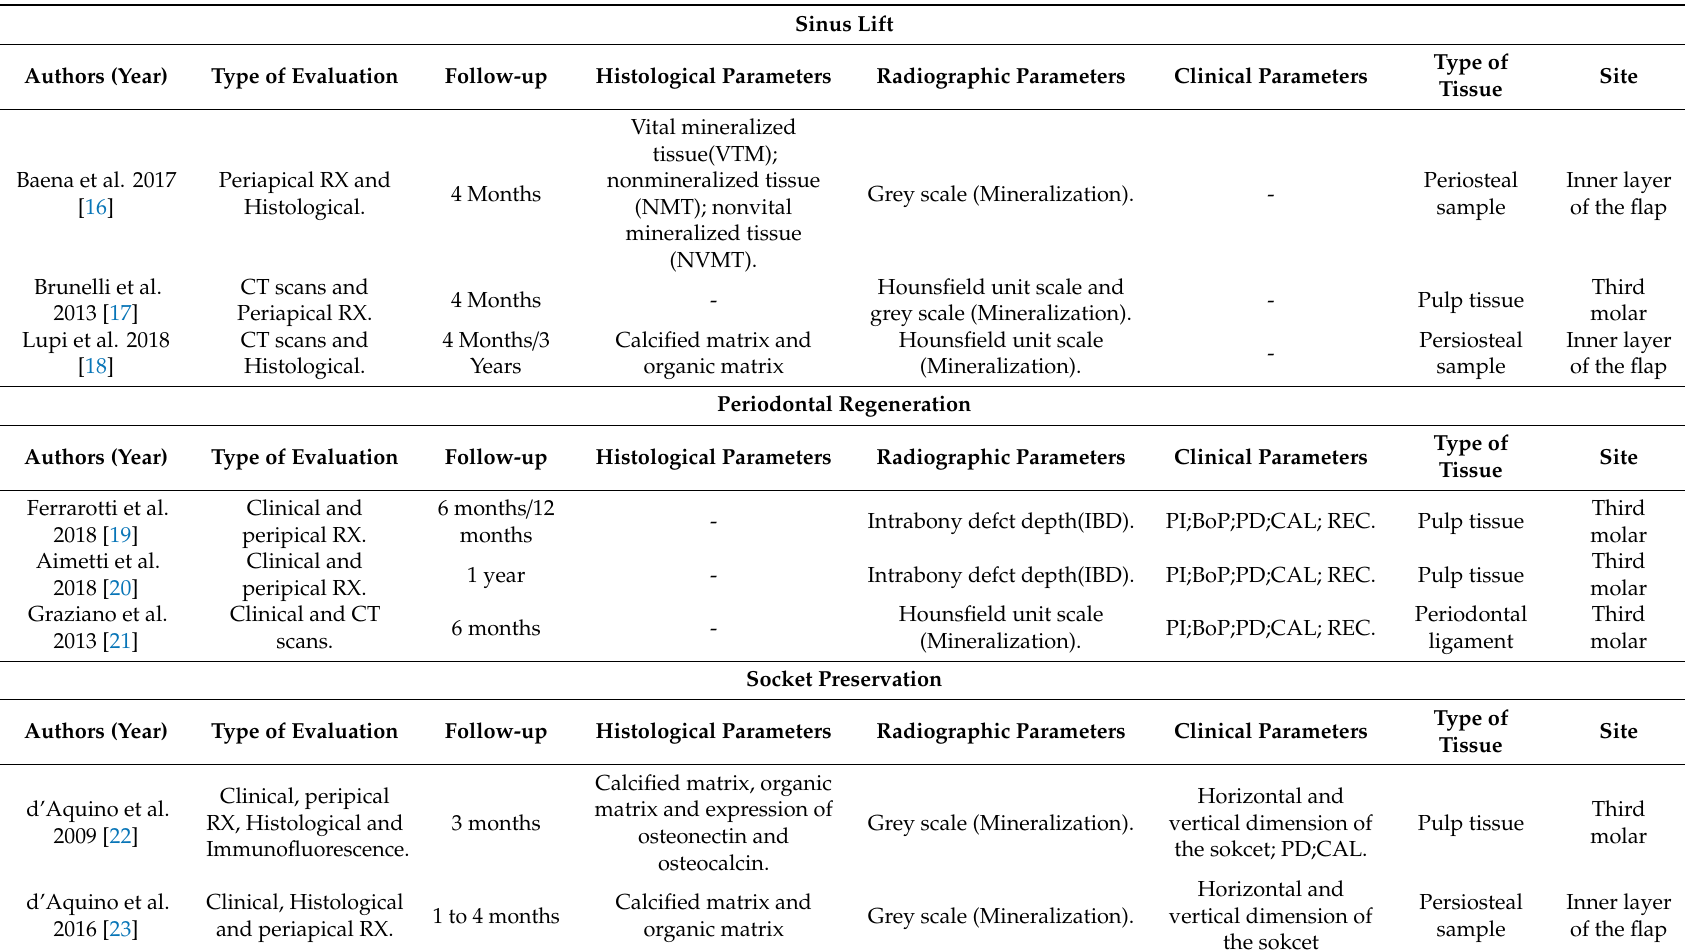
Table 2. Characteristics of each study for type of